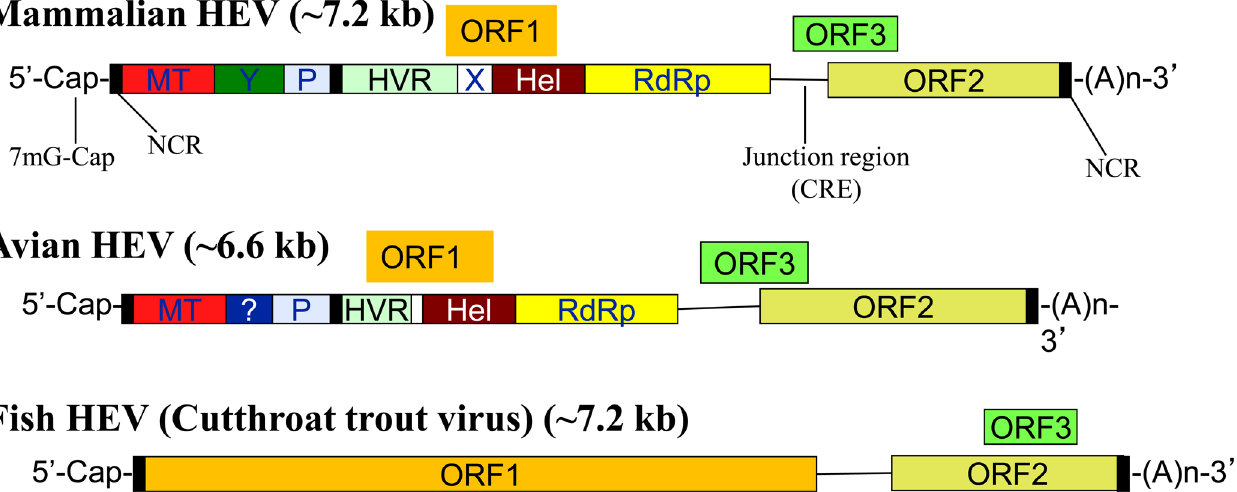
Fig 1. A schematic diagram of comparative genomic organization of mammalian, avian, and fish HEV. The three open reading frames (ORFs) are labeled and shown as boxes. ORF2 overlaps ORF3, but neither overlaps ORF1. ORF1 encodes nonstructural proteins with the putative functional domains within ORF1 indicated inside the box. ORF2 encodes the capsid protein, and ORF3 encodes a small protein that is involved in virus replication. The genome is capped (m7G Cap) at the 5 0 end and contains a poly A tail at the 3 0 end. There are noncoding regions (NCR) at the 5 0 and 3 0 ends of the viral genome. There is a junction region between ORF1 and ORF3 for mammalian and avian HEV, which contains a stem-loop structure and a cis-reactive element (CRE). The avian HEV genome is approximately 600 bp smaller than the mammalian and fish HEV. Hel, helicase; HVR, hypervariable region; MT, methytransferase; NCR, noncoding region; P, a papain-like cysteine protease; RdRp, RNA-dependent RNA polymerase; X, macro domain.